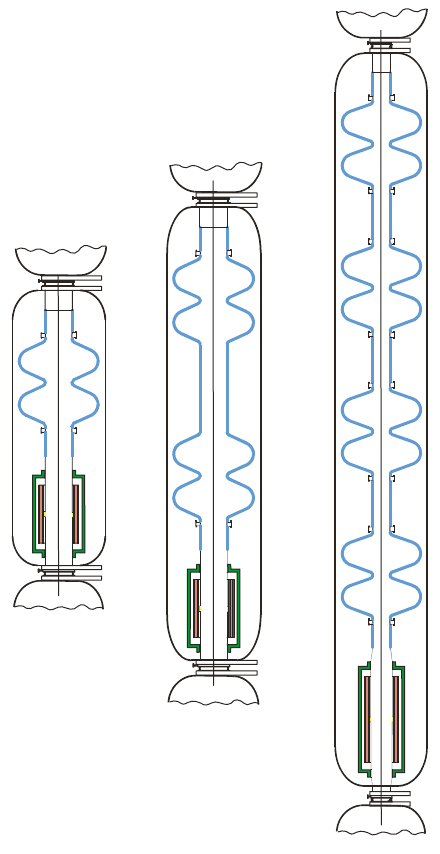
FIG. 22. (Color) Layouts of short (left), intermediate (middle), and long (right) cryomodules. Blue lines are the SC walls of the cavities. Solenoid coils are indicated in